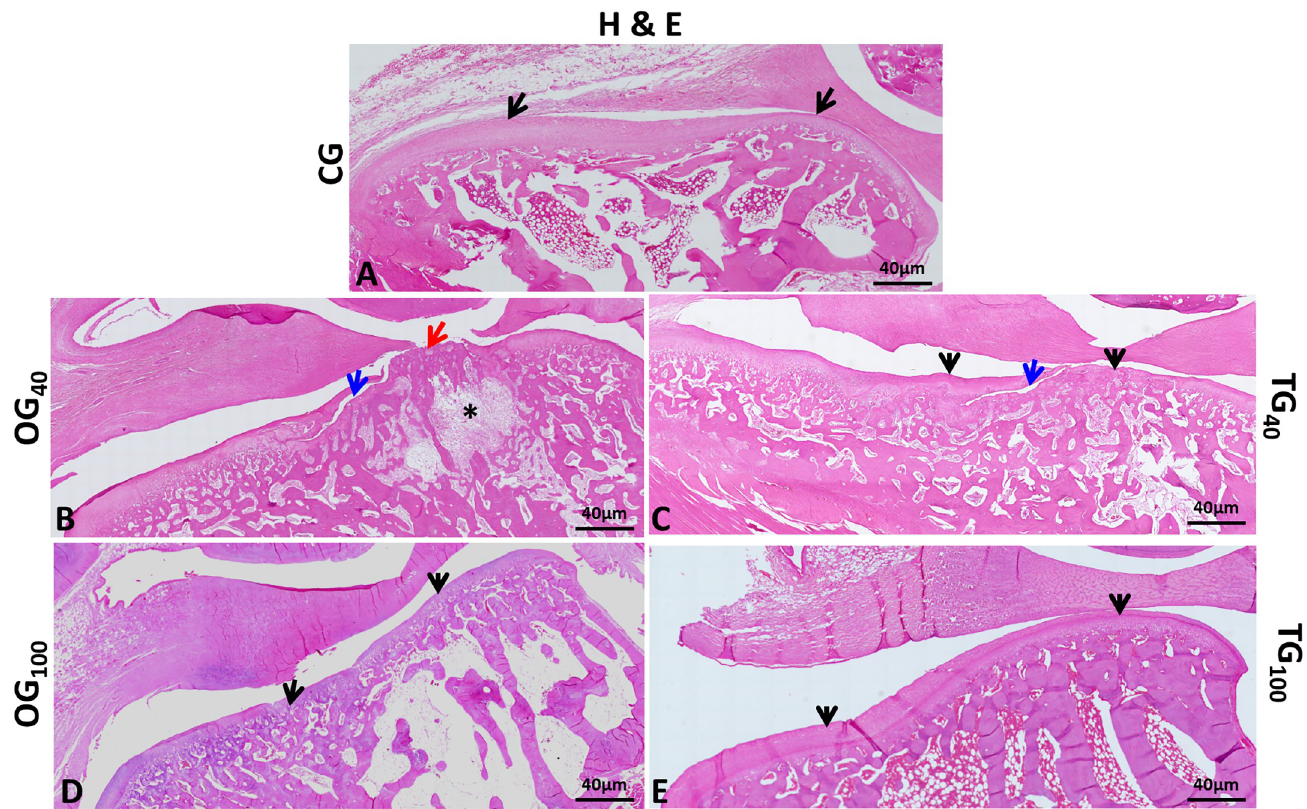
Fig 4. Histologic appearance of the mandibular condyle surface. (A) Control group—TMJ showing normal tissue structures and anatomically normal condyle; characteristic convexity in the anterior region; normal cartilage layer (arrows); intact articular disc. (B and D) OG 40 and OG 100 —TMJ showing anatomic changes caused by OA. Condylar flattening and deformation; decreased cartilage thickness (black arrows); loss of cartilage matrix (red arrow); crack reaching the subchondral bone tissue (blue arrow); subchondral irregularities; degeneration of bone trabeculae with intra-articular cyst formation ( � ); tear of the articular disc. (C) TG 40 —Decreased cartilage thickness (black arrows); presence of substantial crack starting at the articular surface and extending in depth (blue arrow); articular disc constricted in the middle. (E) TG100—Tissues with normal appearance; anatomically normal articular condyle; typical condylar convexity in the anterior region; cartilage layer without changes (arrows); intact articular disc. (TMJ: temporomandibular joint, OA: osteoarthritis, OG 40 : osteoarthritis group at 40 days, OG 100 : osteoarthritis group at 100 days, TG 40 : treatment group at 40 days, TG 100 : treatment group at 100 days).